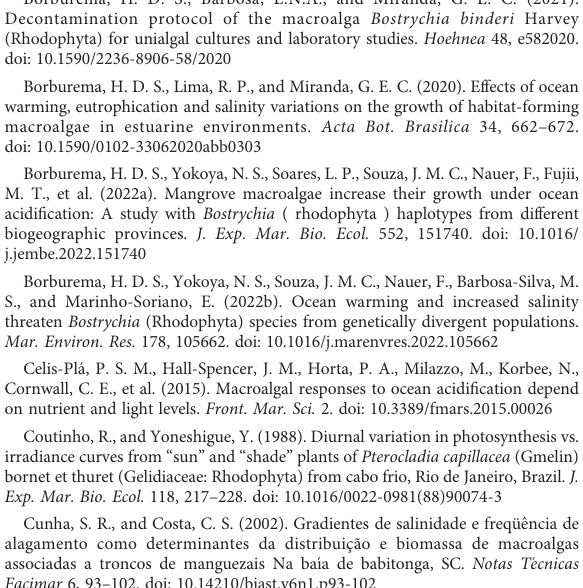
Figueroa, F. L., Celis-Pla ́ , P. S. M., Mart ı ́ nez, B., Korbee, N., Trilla, A., and Arenas, F. (2019). Yield losses and electron transport rate as indicators of thermal